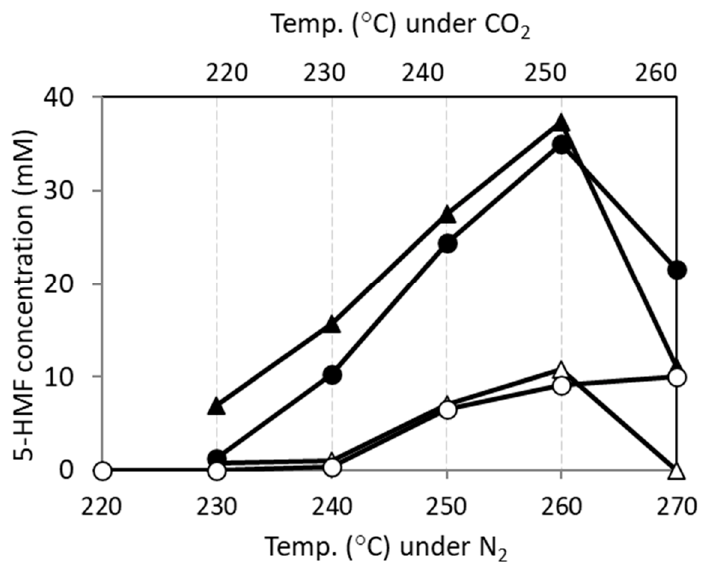
Figure 4. Concentrations (mM) of 5-HMF before (filled symbols) and after (open symbols) AC treat- ment for experiments prepared under CO 2 ( ▲ , △ ) and N 2 ( ● , ○ ) at different reaction temperatures. Results shown are average values of two experiments with variation within ±5%.